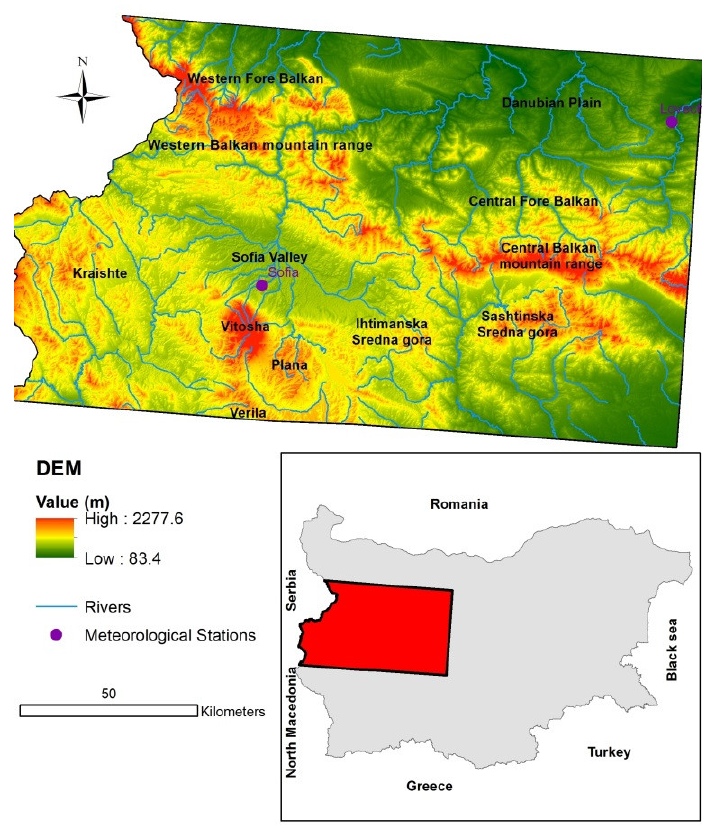
Figure 1. Study area and meteorological stations.